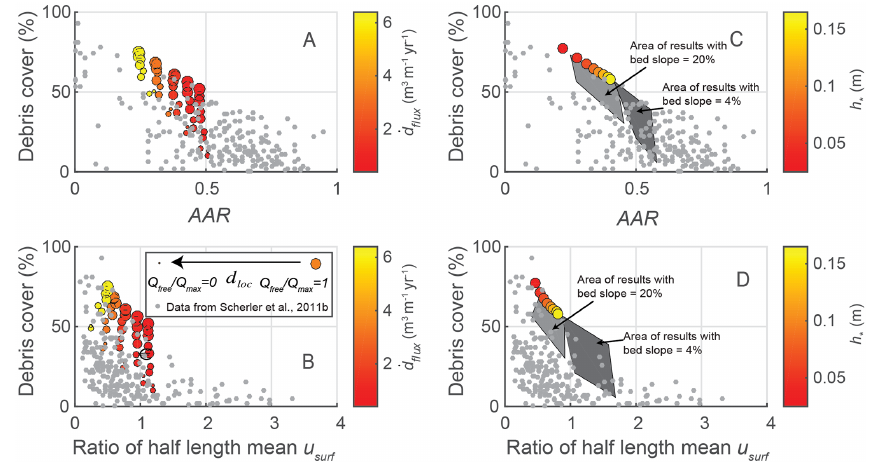
Figure 11. Comparison of our hypothetical steady state debris-cover model output with data from 287 glaciers showing broad patterns between debris and basic glacier properties (Scherler et al., 2011b). (a) The AAR compared to debris cover percentage, debris flux ( ˙ d flux ), and debris deposition location ( d loc ). (b) The ratio of the average surface speed of the lower 50% of the glacier and the average surface speed of the upper 50% of the glacier vs. debris cover percentage, ˙ d flux , and d loc . (c, d) Same data as (a, b) , but exploring the effect of changing the bed slope and h ∗ . The quadrangles show the area occupied by simulation results using the same parameters from (a, b) but with lower and higher bed slopes. h ∗ results are from the parameter test where h ∗ is varied (Fig.